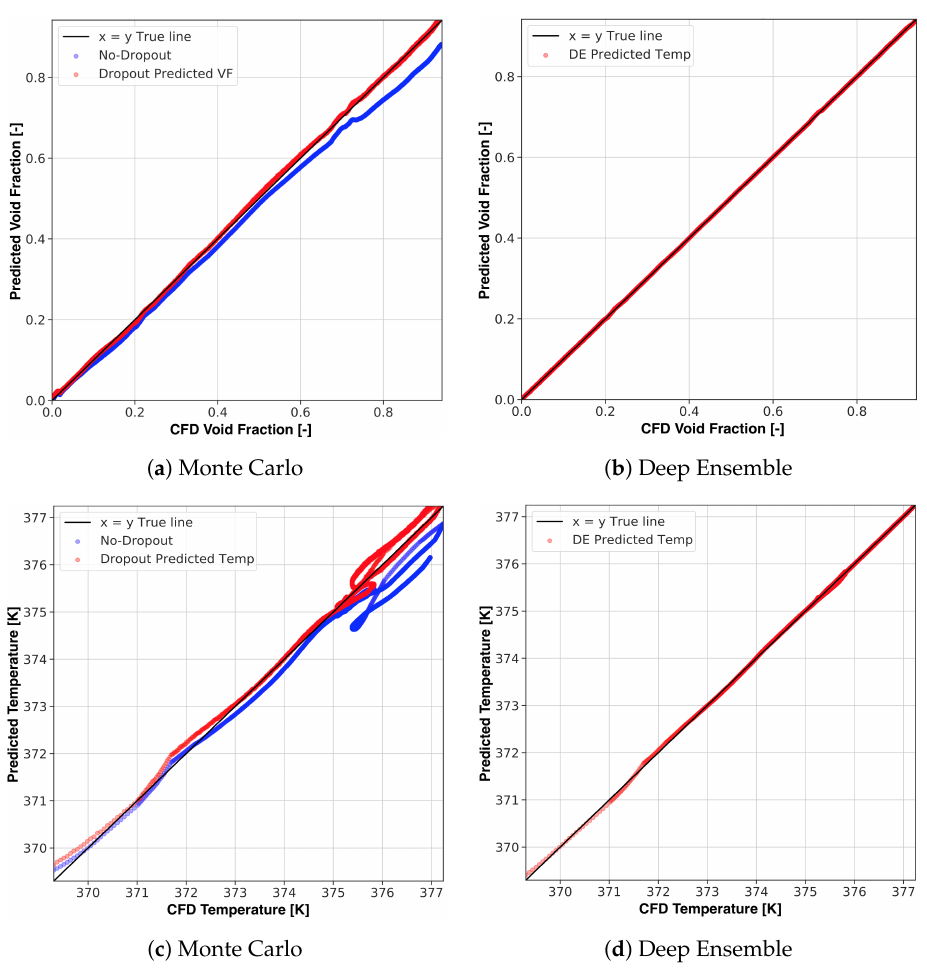
Figure 6. Regression chart for interpolation dataset using Monte Carlo and Deep Ensemble for void fraction and wall temperature at q (cid:48)(cid:48) =14,000 Wm − 2 and u = 0.05 ms − 1 .